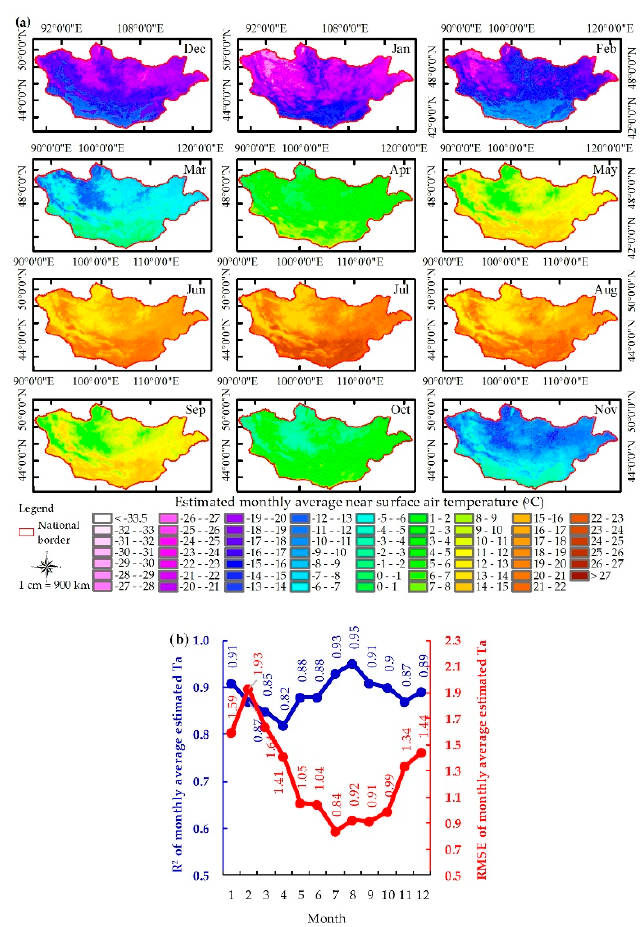
Figure 7. Estimated monthly average Ta based on RF regression model using LSTd, LSTn, and elevation as predictor variables. ( a ) Spatial maps of estimated monthly average Ta over Mongolia at 1 km spatial resolution. ( b ) Monthly statistics of R 2 (blue) and RMSE (red) between observed and predicted air temperature.